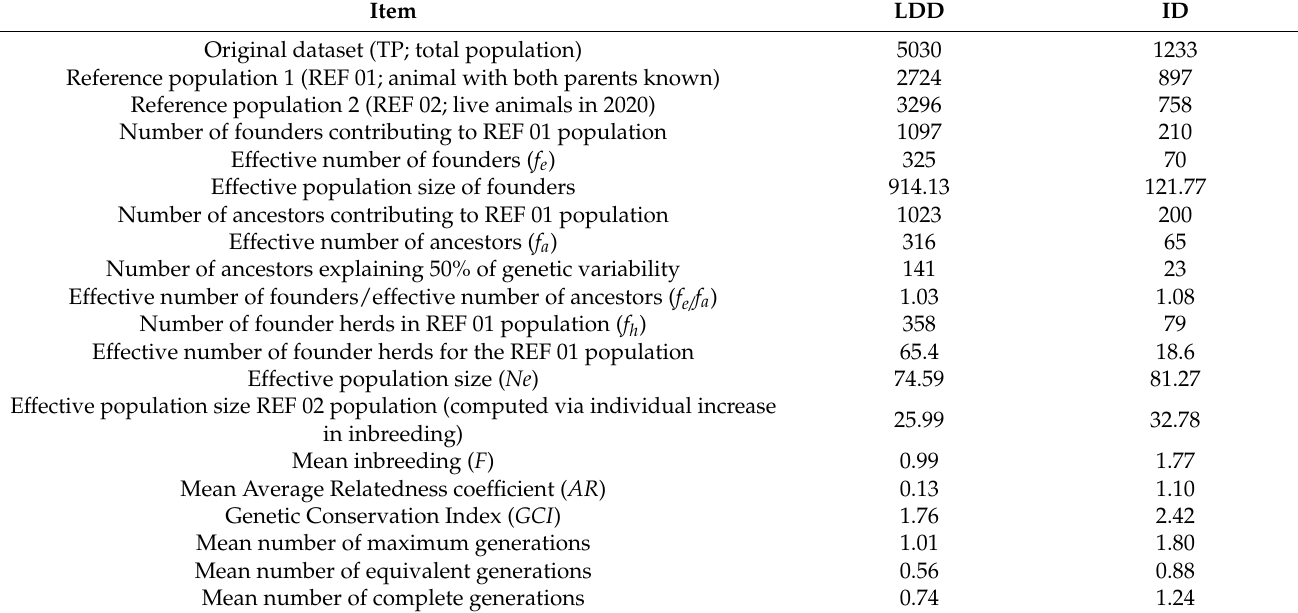
Table 1. Summary statistics of the pedigree analysis of the Littoral-Dinaric donkey (LDD) and Is- trian donkey (ID) populations.